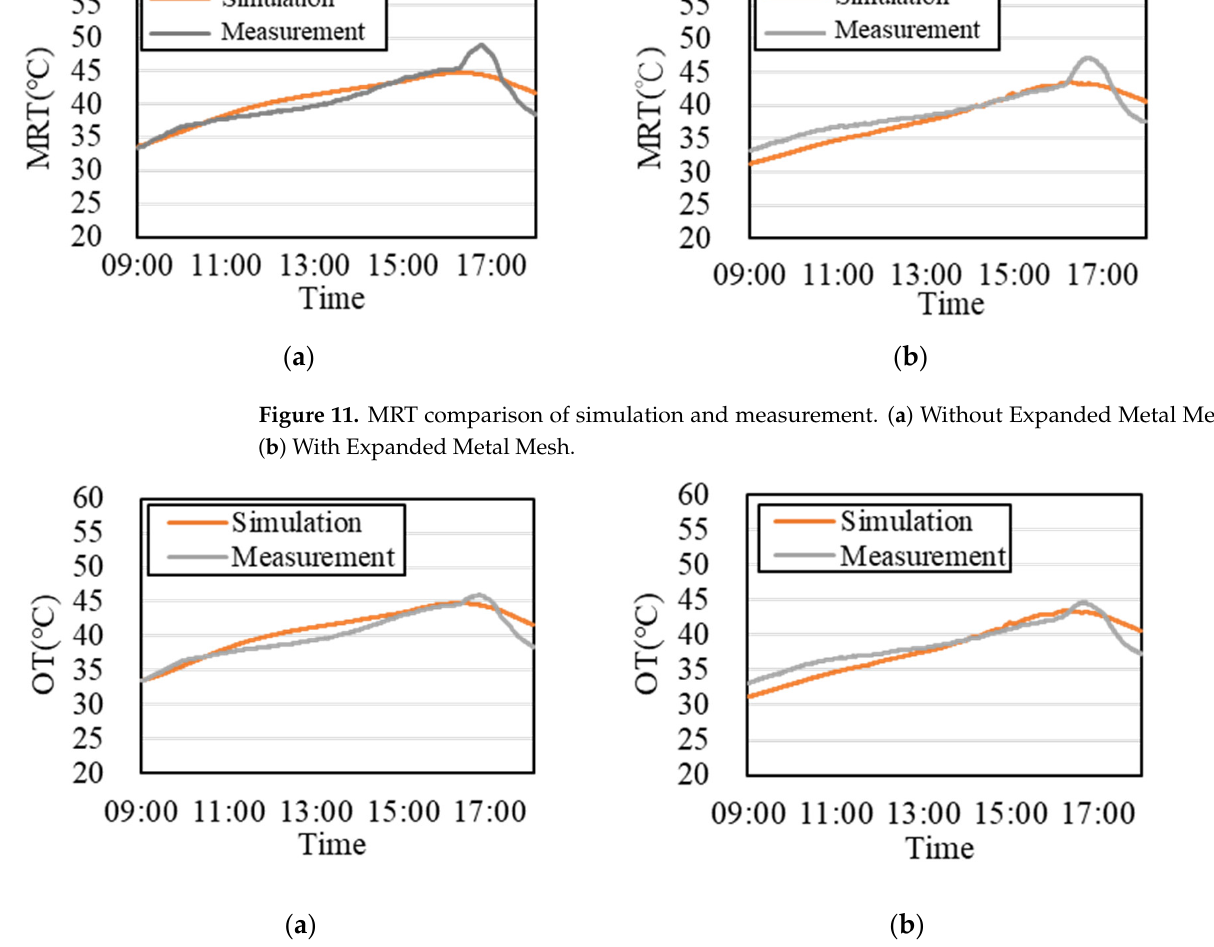
Figure 12. OT comparison of simulation and measurement. ( a ) Without Expanded Metal Mesh; ( b ) With Expanded Metal Mesh.